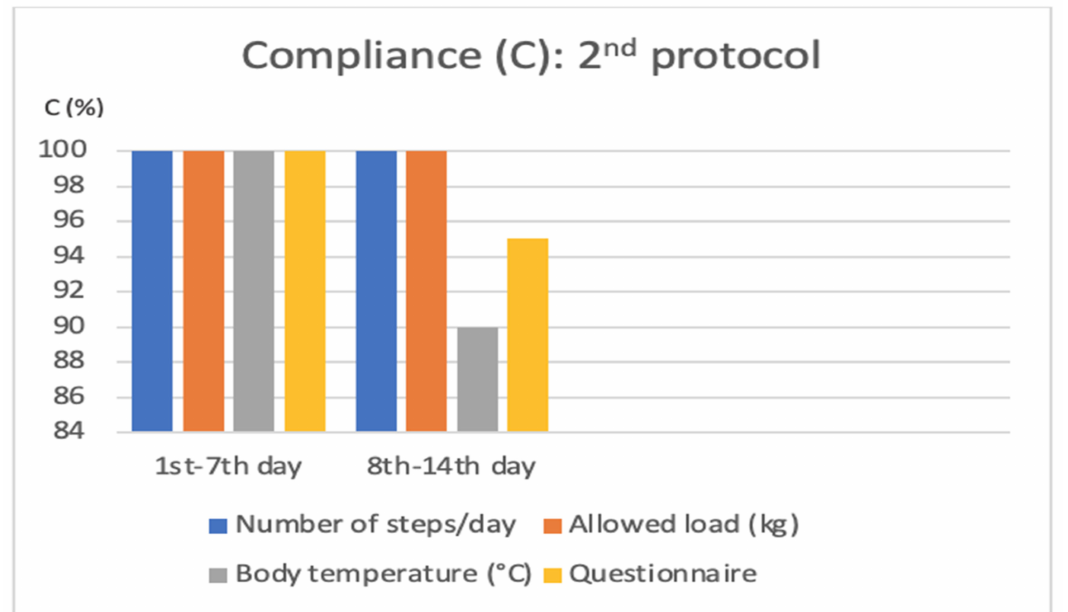
Figure 5. Graphical representation of average patient compliance, expressed as a percentage, in the insertion of the various parameters required within the second